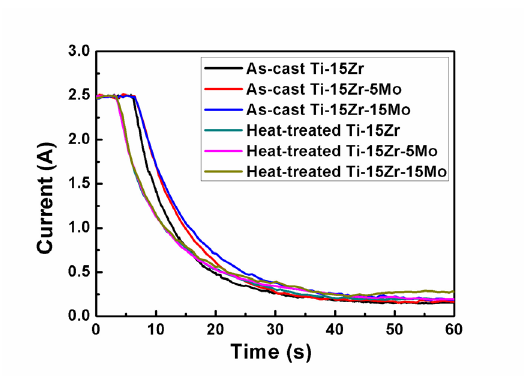
Figure 3: Current-time curves of the MAO treatments.